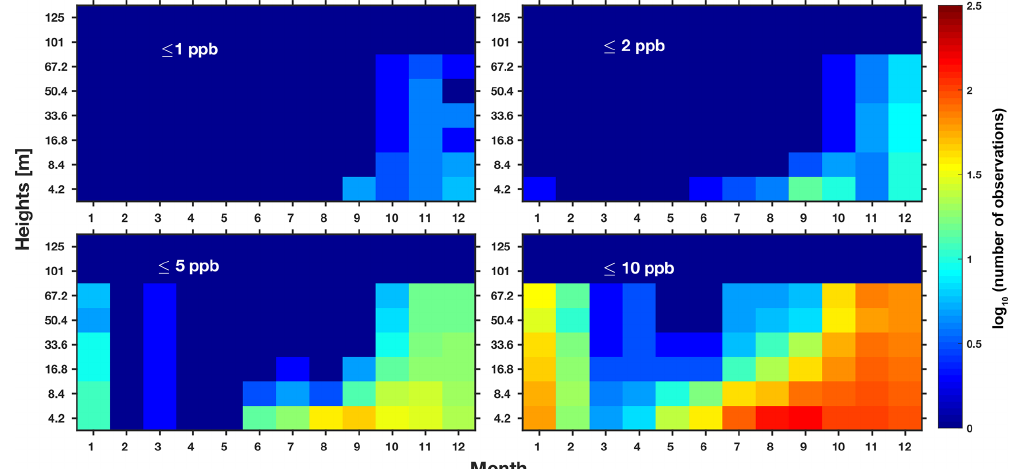
Figure 5. Vertical extension of ozone depletion events that last longer than 30min. The numbers of depletion event observations are colour coded in logarithmic scale for ozone concentration drops below 10, 5, 2, and